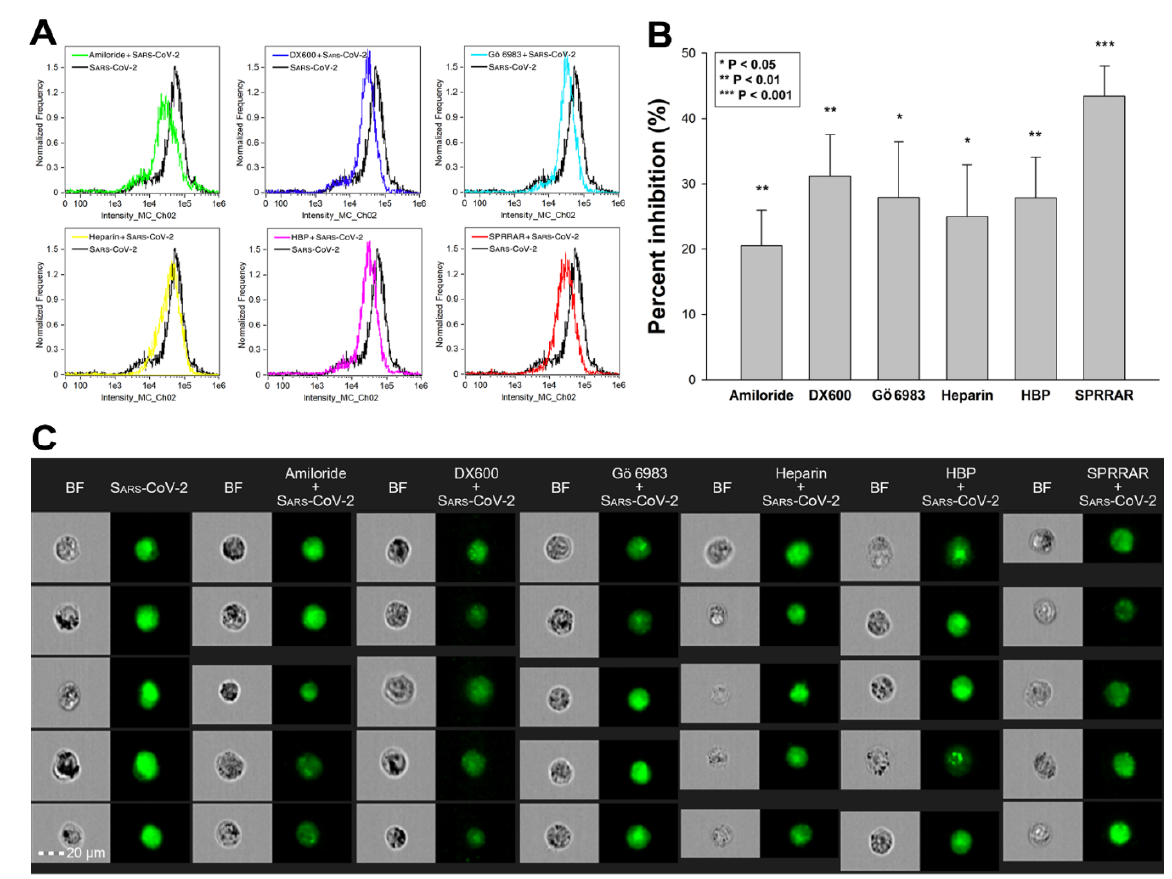
Figure 9. Effects of ACE2 or SDC4 inhibition on SARS-CoV-2 uptake in A549 cells. ( A ) Cellular images of SARS-CoV-2- treated WT A549 cells preincubated with or without either of the inhibitors: amiloride, DX600, Gö 6983, heparin, HBP and SPRRAR. After 18 h of incubation, the cells were washed, trypsinized, fixed, permeabilized and treated with antibodies specific for the spike glycoprotein (along with AF 488-labeled secondary antibody). Intracellular fluorescence was then analyzed with imaging flow cytometry. ( B ) Flow cytometry histograms representing intracellular fluorescence of SARS- CoV-2-treated WT A549 cells preincubated with or without any inhibitors. ( C ) The effect of an inhibitor was expressed as percent inhibition, calculated with the following formula: [(X − Y)/X] × 100, where X is the fluorescence intensity obtained on cells treated with SARS-CoV-2 in the absence of the inhibitor, and Y is the fluorescence intensity obtained on cells treated with SARS-CoV-2 in the presence of the inhibitor. The bars represent the mean ± SEM of four independent experiments. Statistical significance vs. controls treated with SARS-CoV-2 in the absence of the inhibitor was assessed with ANOVA. * p < 0.05; ** p < 0.01; *** p < 0.001.